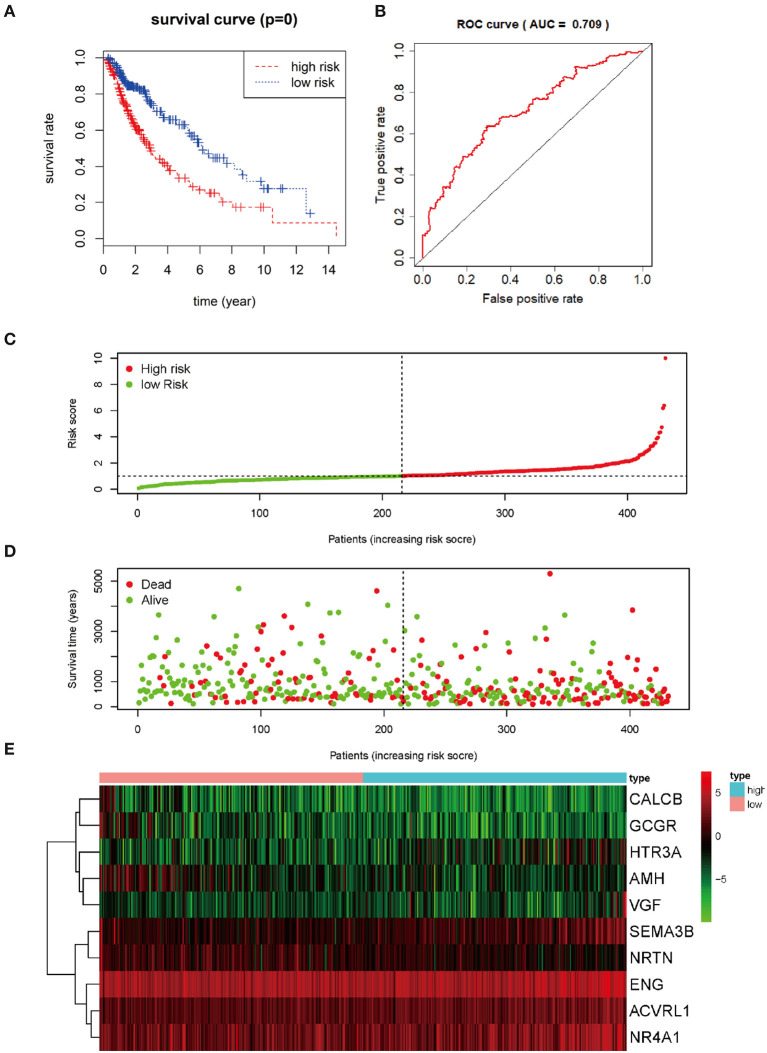
Prognosis value of 10 differential expression IRGs in LUSC patients. (A) Kaplan-Meier curve analysis for OS (overall survival) in LUSC patients using the 10 differential expression IRGs signature. (B) ROC curve analysis of the prognostic 10 differential expressions IRGs signature. (C) The risk score analysis of prognostic 10 differential expressions IRGs signature in LUSC high-risk group and low-risk group. (D) The survival status analysis of prognostic 10 differential expressions IRGs signature in LUSC high-risk group and low-risk group. (E) A risk heat-map constructed from 10 differential expression IRGs from 431 LUSC patients.